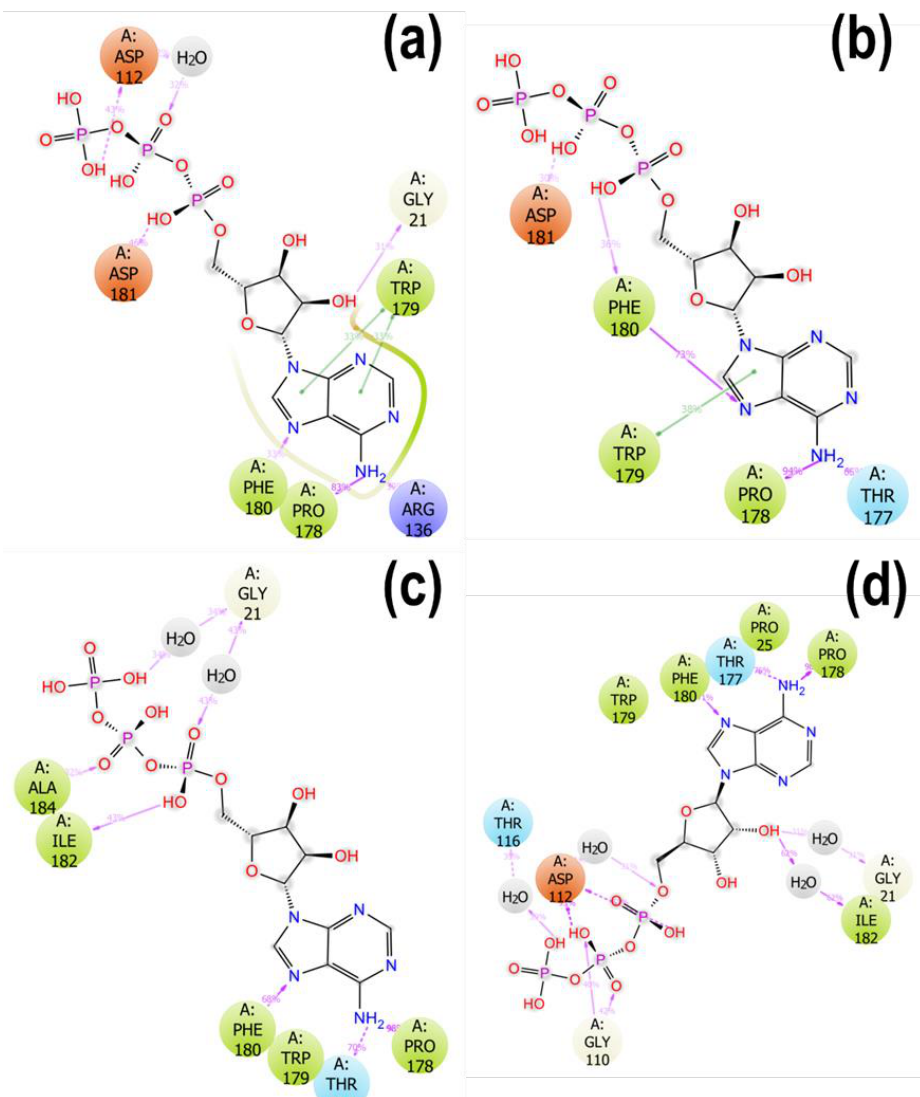
Figure 9. 2D interaction plot showing KpNNAT-ATP interactions that occur for more than 30.0% of the 100 ns simulation time for ( a ) no metal ( b ) Mg 2+ ( c ) Ca 2+ and ( d ) Zn 2+